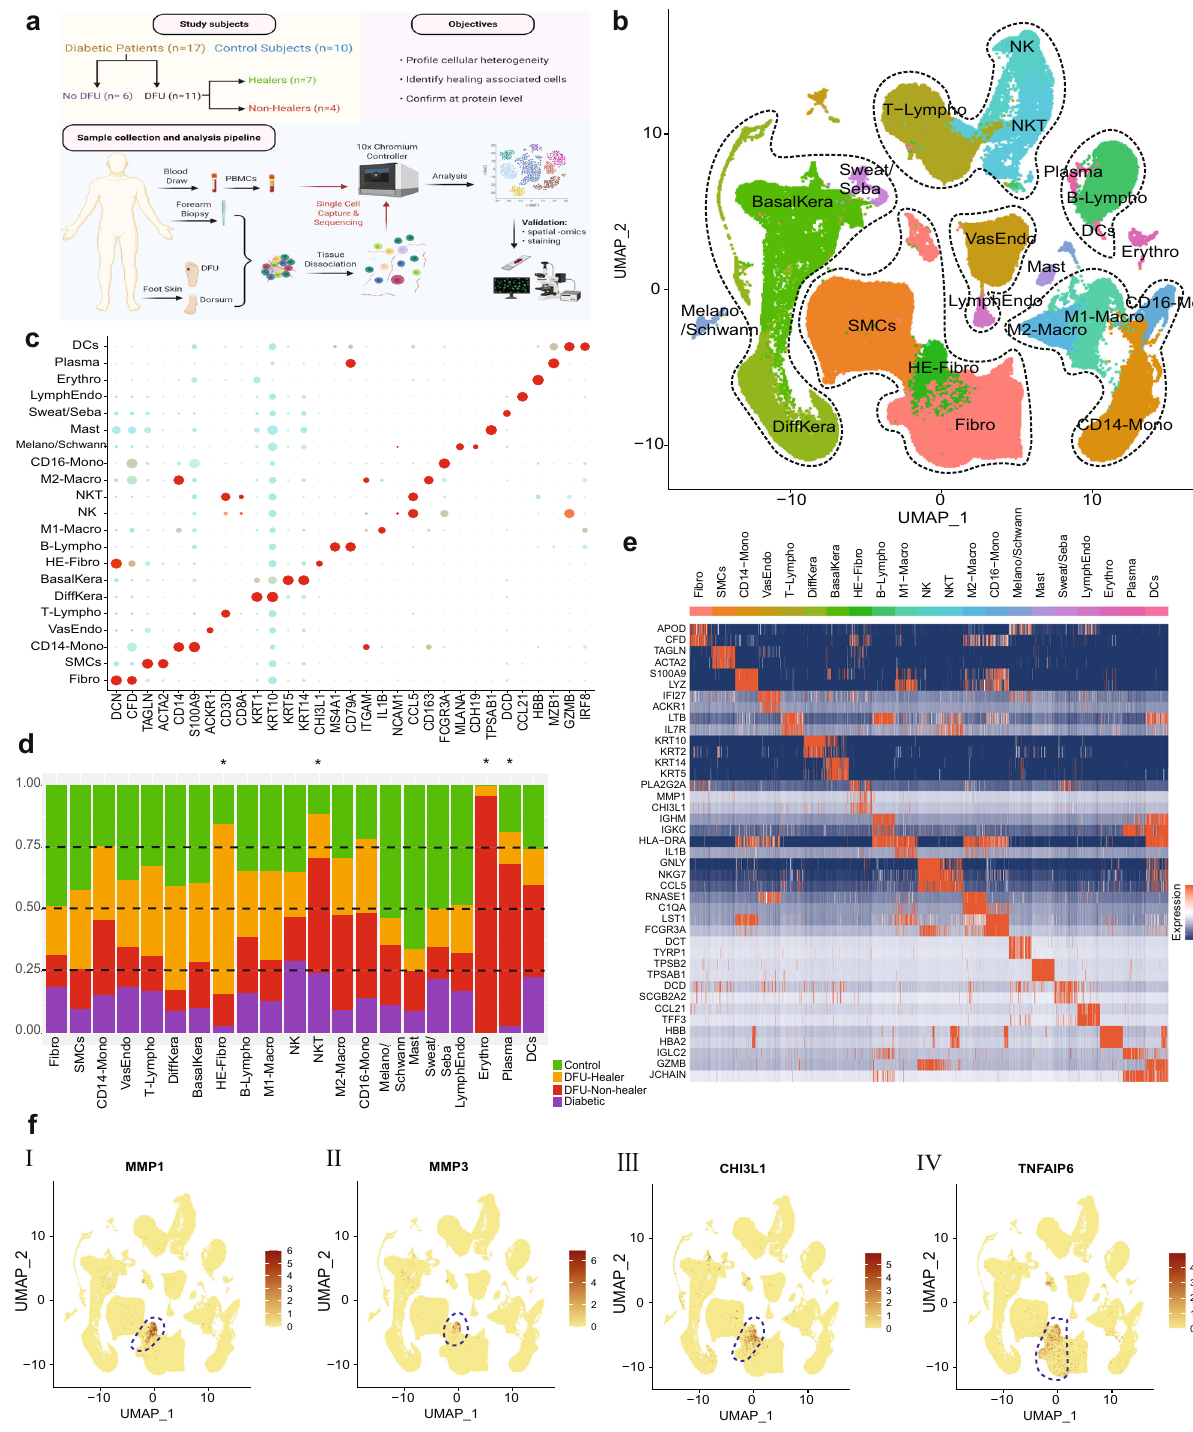
repair in DFU-Healers. The top 10 overexpressed genes from the annotated cell clusters are included in Supplementary Dataset 1. Exploring cellular heterogeneity across different anatomical sites . To assess tissue speci fi c cellular heterogeneity along with gene expression and molecular pathway alterations, we generated the UMAP rendering split based on foot, forearm, or PBMC samples (Fig. 2a). The analysis depicted signi fi cant variations in the abundance of cell types based on anatomical sites (Fig. 2b). NATURE COMMUNICATIONS| (2022) 13:181